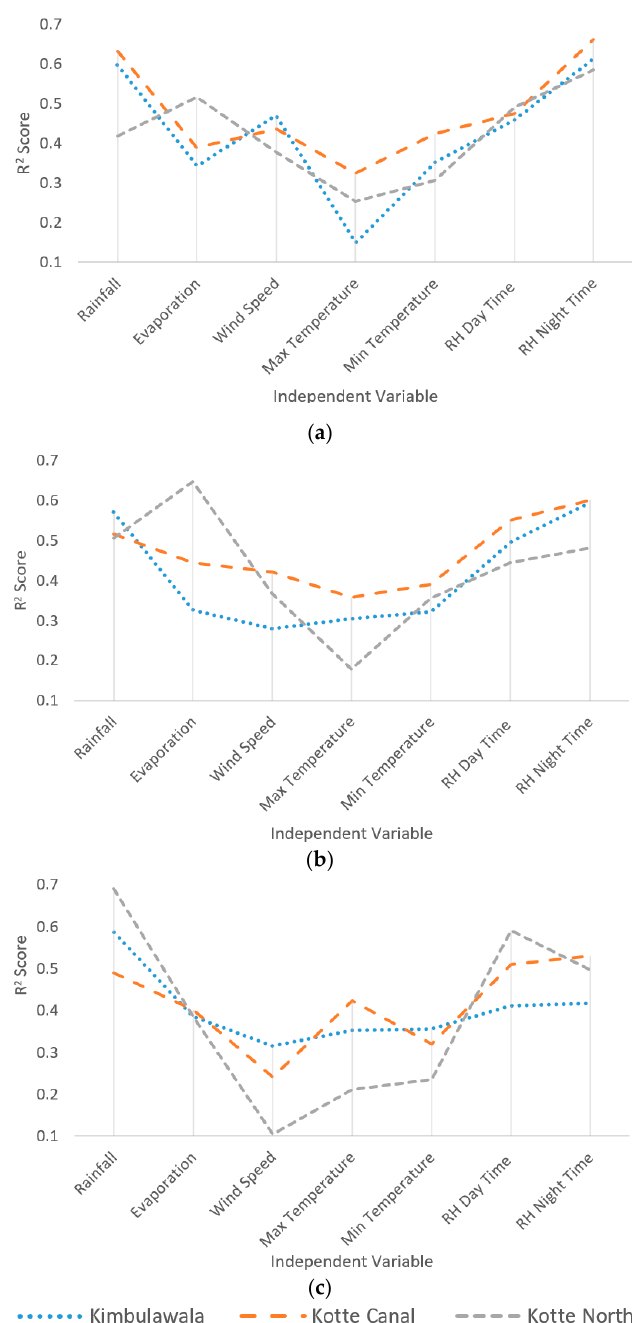
Figure 3. Sensitivity Analysis (R 2 Score): ( a ) under the Levenberg Marquardt algorithm; ( b ) under the Bayesian Regularization algorithm; ( c ) under the Scaled Conjugate Gradient algorithm.